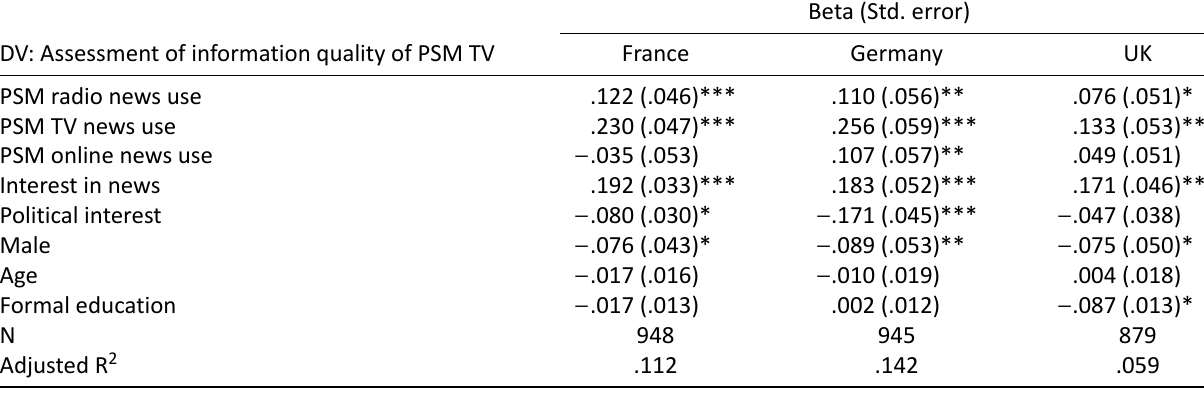
Table 5. Effects on the assessment of information quality of PSM TV in France, Germany, and the UK (multiple linear